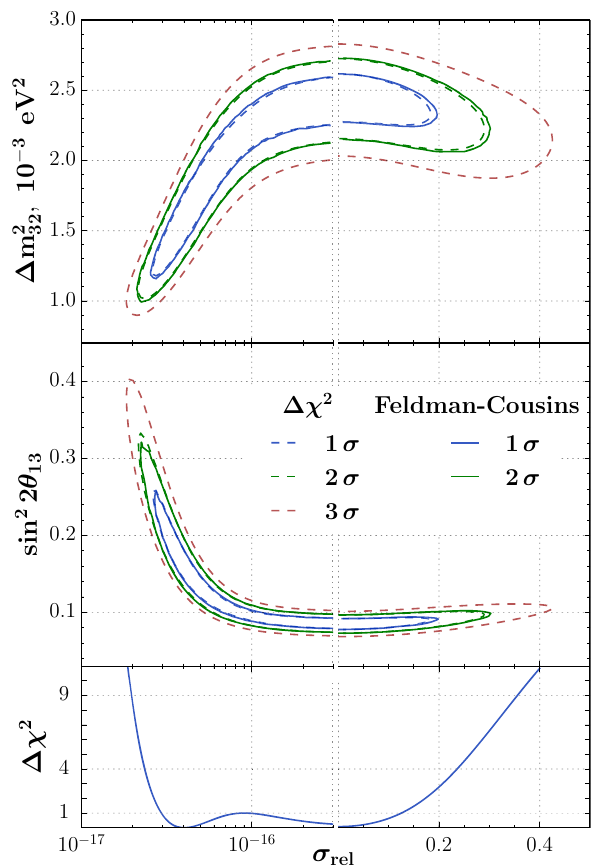
,σ ) ( top ) and of ( sin 2 2 θ ,σ ) rel 13 rel 32 = 0 . 160 13